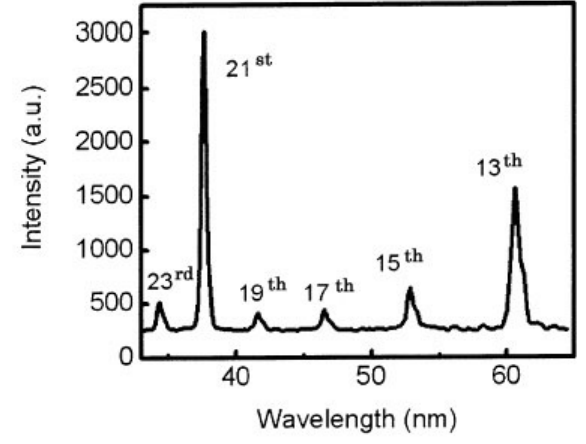
Figure 7. An intense exact resonance enhancement of single high-harmonic from an antimony ion by using Ti:sapphire laser at 37 nm was obtained. The intensity of the 21st harmonic was 10 times higher than those of the 23rd and the 19th